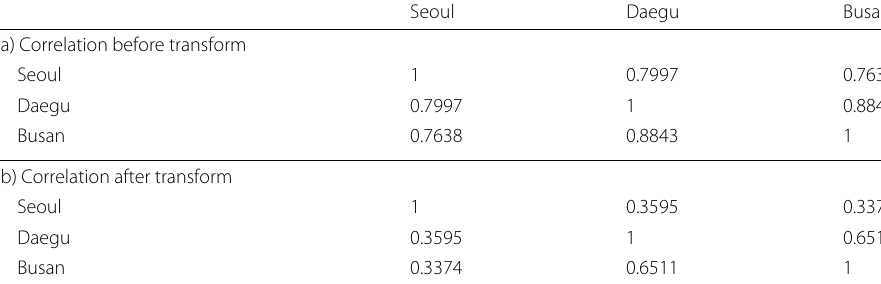
Table 3 Correlation of solar radiations between Seoul, Daegu, and Busan Seoul Daegu Busan (a) Correlation before transform Seoul 1 0.7997 0.7638 Daegu 0.7997 1 0.8843 Busan 0.7638 0.8843 1 (b) Correlation after transform Seoul 1 0.3595 0.3374 Daegu 0.3595 0.6511 Busan 0.3374